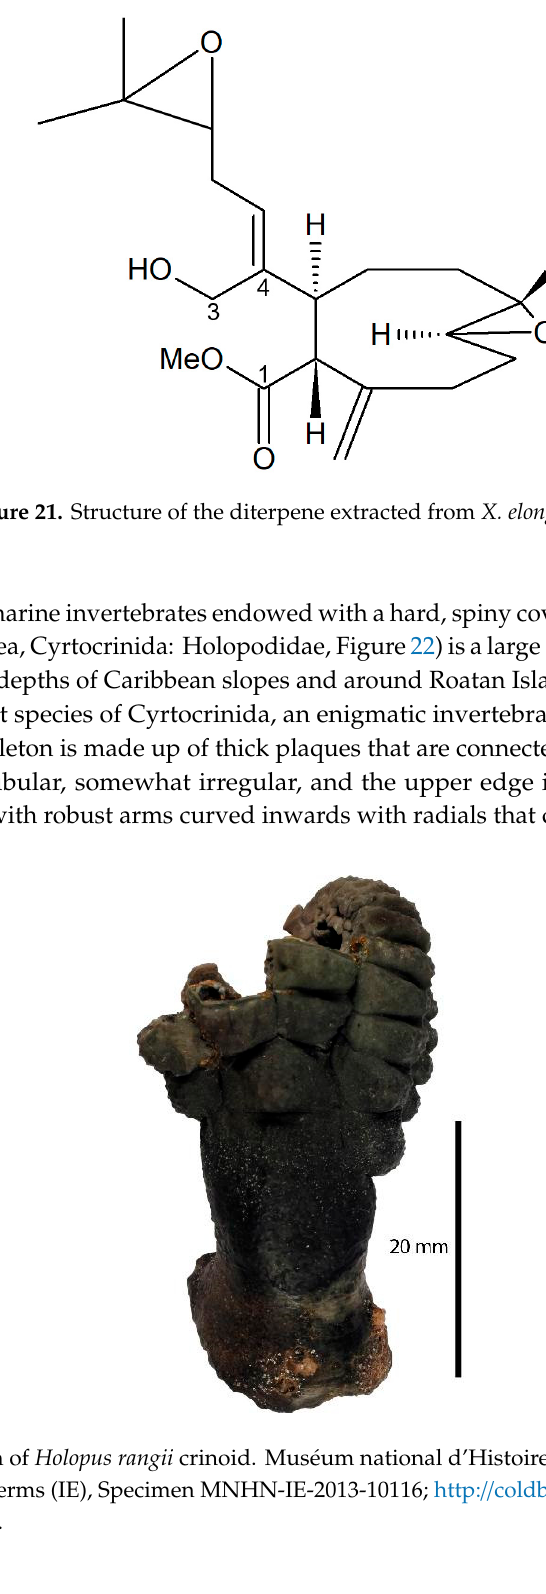
Figure 20. Specimen of Xenia elongata soft coral. ( A ) Photo of holotype in dry conditions. ( B ) Colony drawing from Dana (1846) [84].